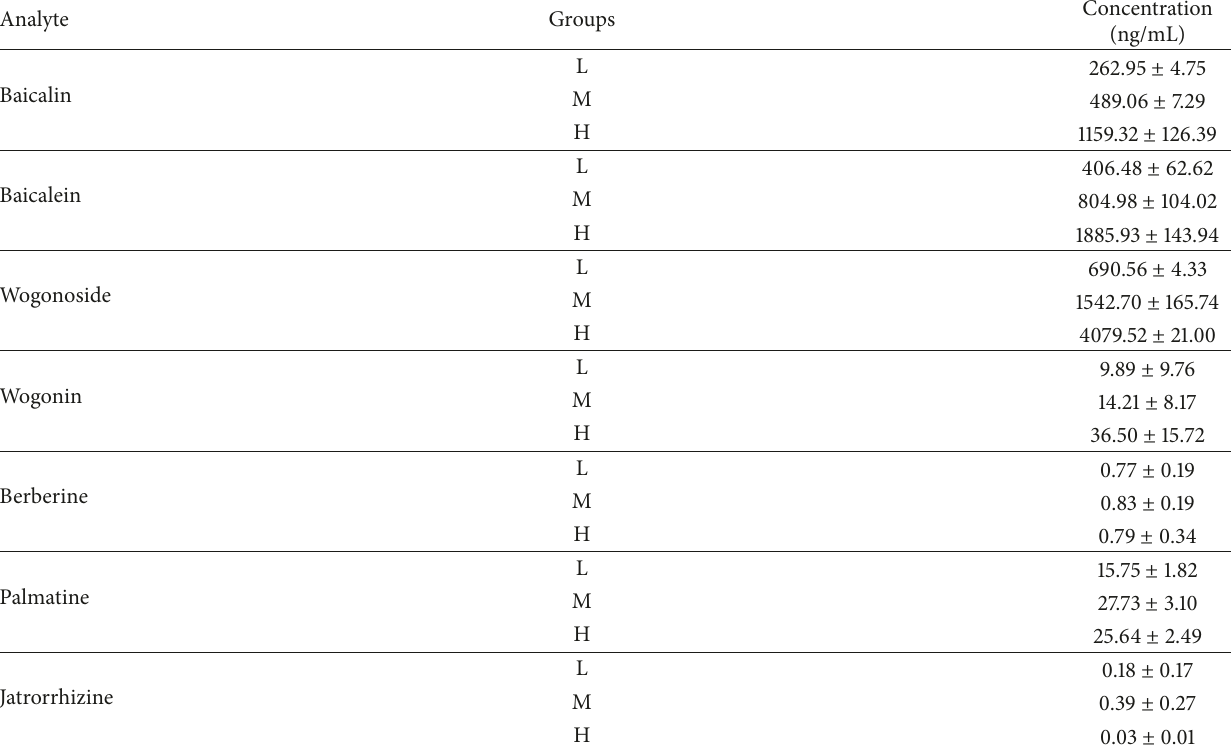
Table 6: The concentration of seven analytes in rat plasma after oral administration of three dosages of HLJDD. Analyte